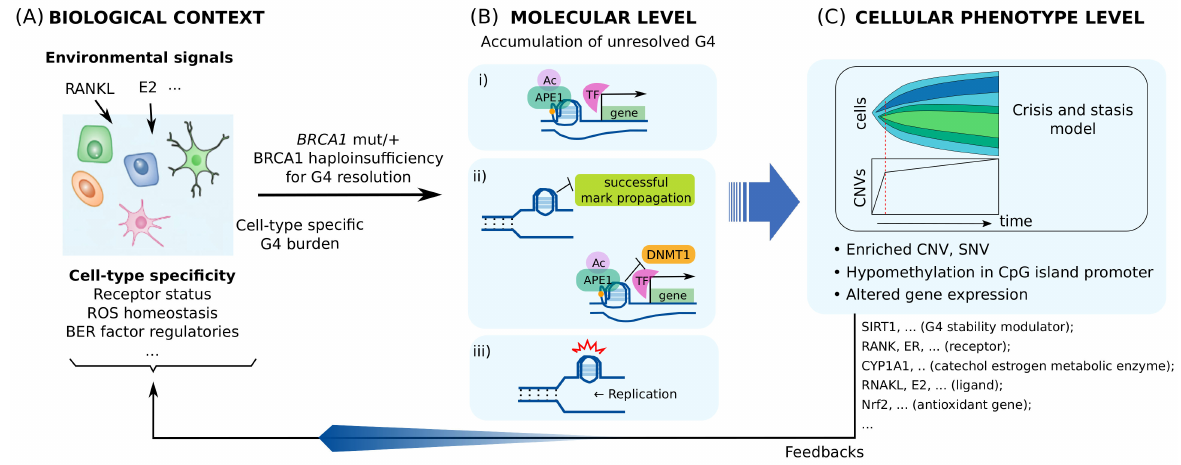
Figure 3. Model for tissue-specific tumorigenesis by BRCA1 deficiency. ( A ) How much of transcription regulatory G4/R-loop is generated at basal level is cell-type specific. ( B ) High burden on G4 processing causes multi-level molecular alterations by BRCA1 haploinsufficiency in the form of: (i) transcriptional alterations, (ii) epigenetic alterations, and (iii) genetic alterations. ( C ) These alterations contribute to phenotype evolution and modify the biological context of the cell by various factors, such as SIRT1, NRF2, estrogen receptor (ER)-E2 signaling, and RANK-RANKL signaling. Clones with the same pattern of copy number variations (CNVs) or single nucleotide variations (SNVs) expand as the tumor grows. One of the clonal expansion models for CNV, the Crisis and stasis model [178], is